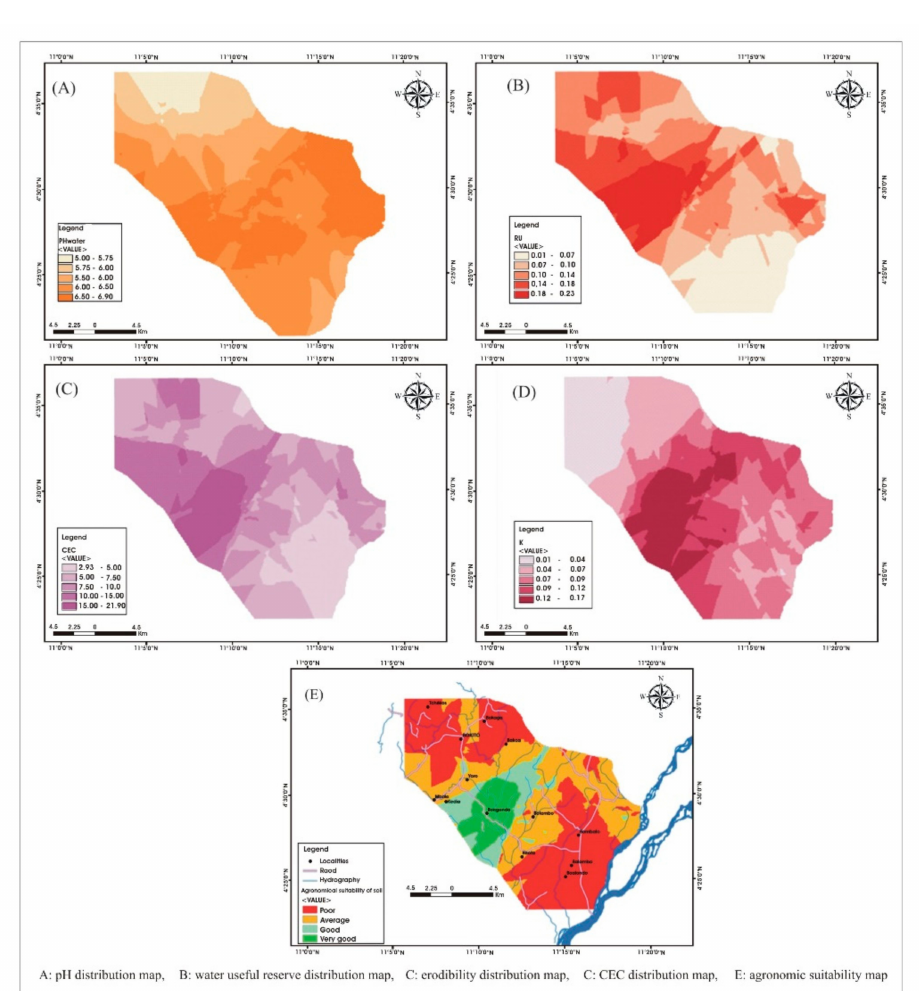
Figure 4. Agricultural suitability